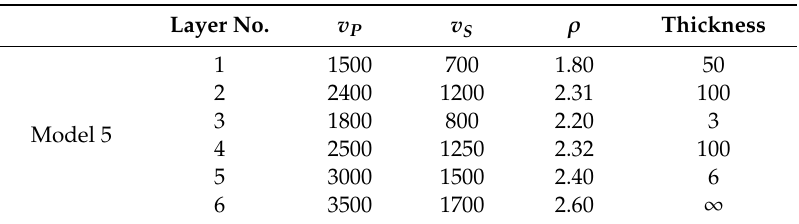
Figure 10. PP-wave AVA gathers of Model 5. Table 2. Parameters of multi-layer models. Units of velocities, densities and thickness in Table 2 are m / s, g / cm 3 and m, respectively.